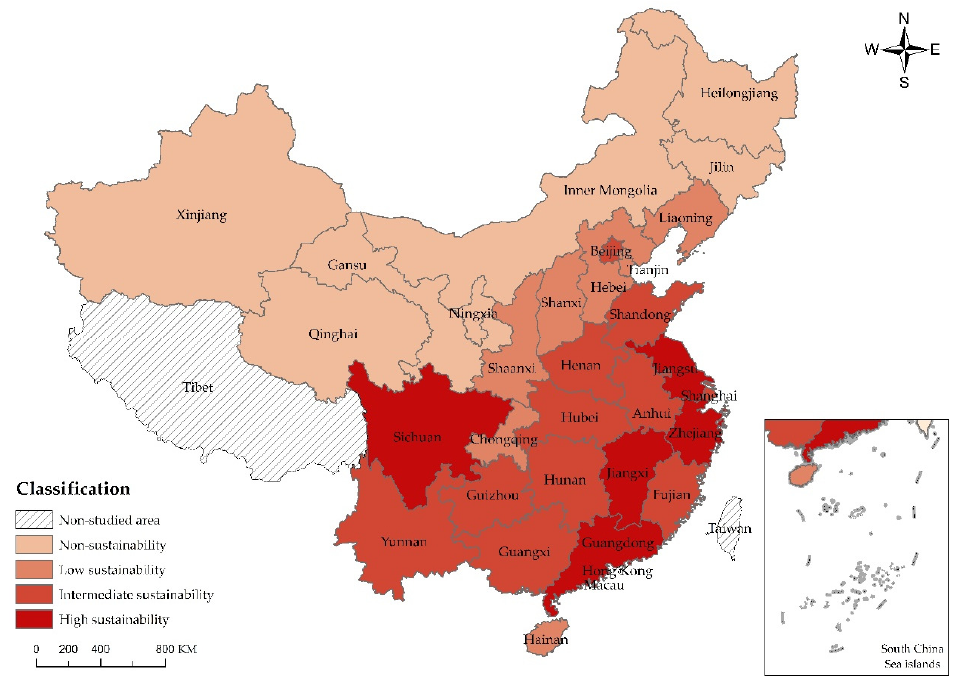
Figure 5. Comparison chart of sustainable capacity of scenic spots in China.